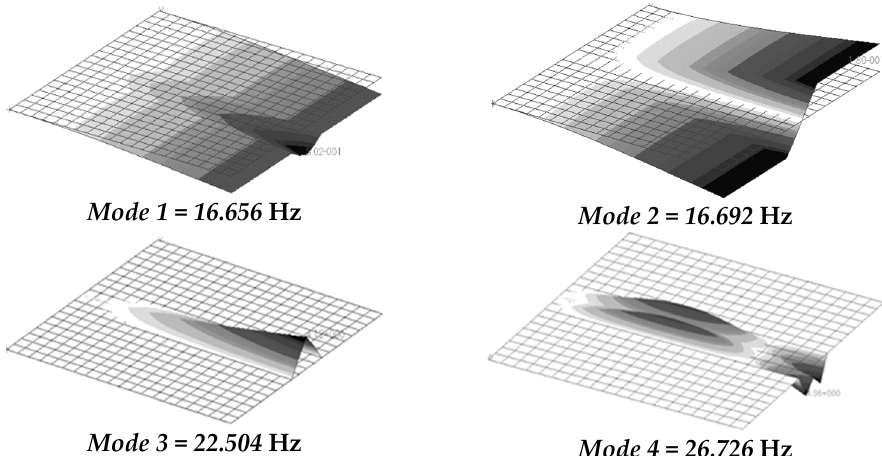
Figure 5. The first four order mode shape of the model with the reinforced stiffener.